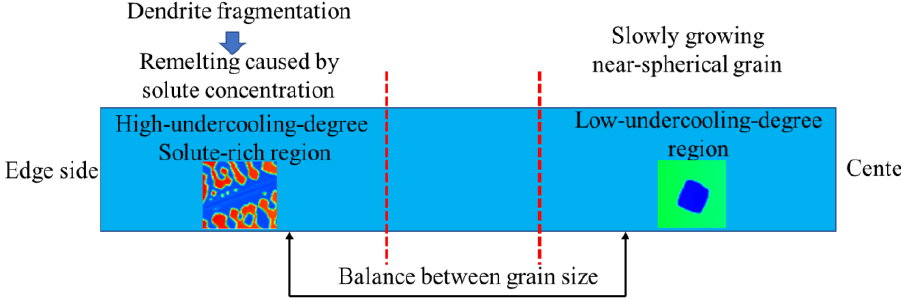
Figure 13. The balance between grain size under different local conditions from edge side to center.